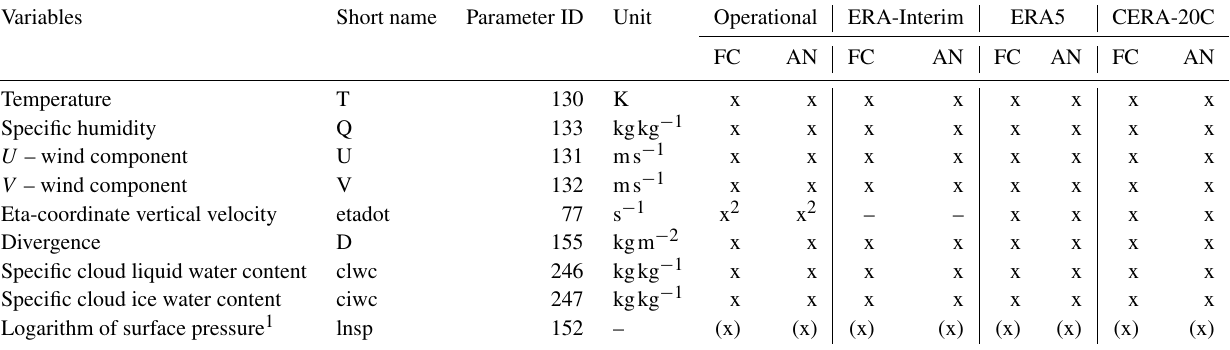
Table 17. List of model level parameters FLEXPART requires to run and the availability in the different data sets (ECMWF, 2019e,i). The cloud-water content fields are optional. The divergence and logarithm or surface pressure fields are only necessary for the calculation of the vertical velocity when ˙ η is not available directly. These fields are not transferred to the FLEXPART input files. FC stands for “forecast” and AN for